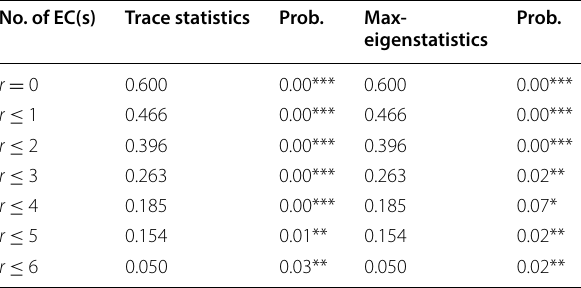
Table 2 Result of Johansen co-integration